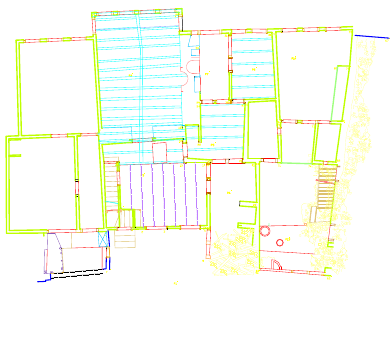
Figure 6. Ground Floor Structural RCP